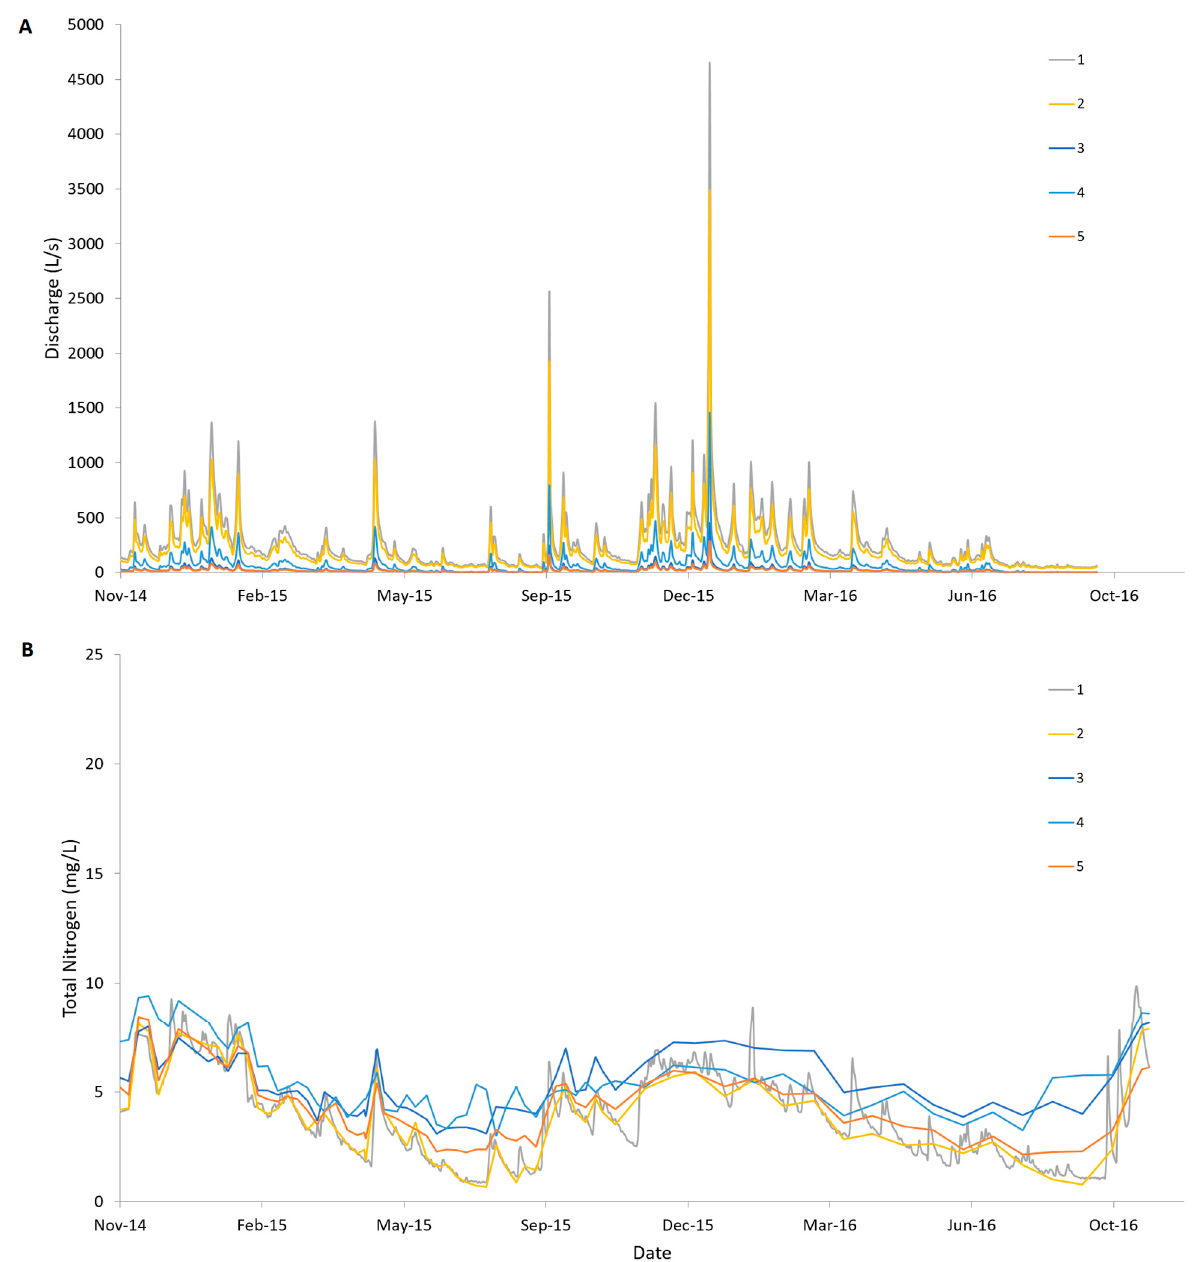
Figure A2. ( A ) Discharge measurement at the synchronous stations in the sub-catchments and at the main gauging station of Odder catchment in the period 2014 to 2016. ( B ) TN concentrations measured at the synchronous stations in the sub-catchment and at the main gauging station of Jegstrup catchment in the period 2014 to 2016. Linear interpolation was used between the weekly and fortnightly grab sample measurements to obtain daily measurements at the synchronous stations.